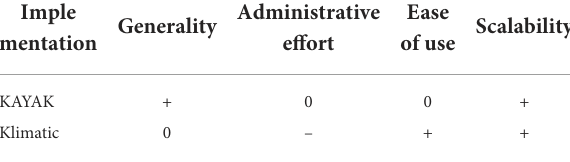
TABLE 4 Comparing the two workflow and automation tools.